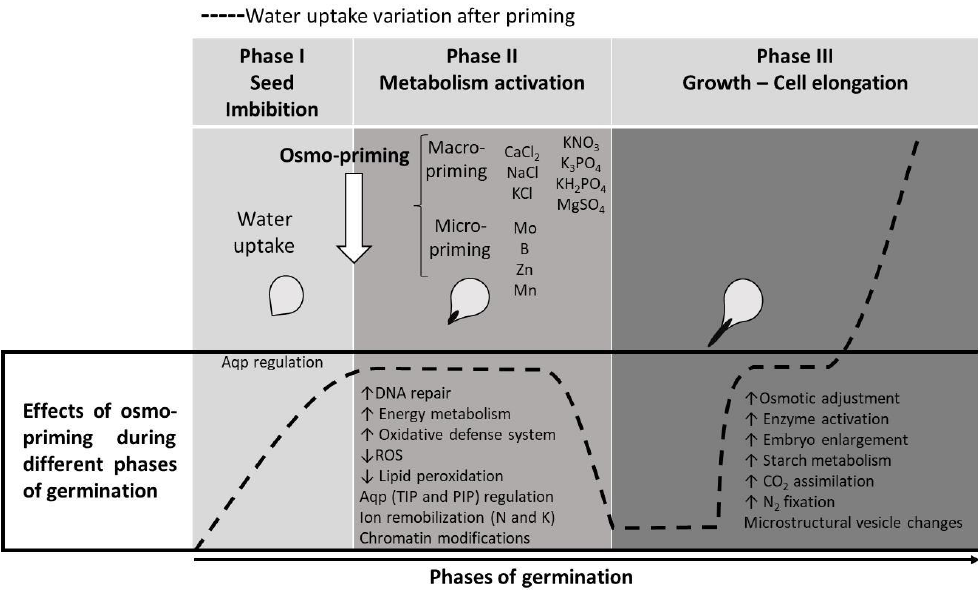
Figure 2. Effects of osmo-priming on water content and different events in the seeds during the Figure 2. E ff ects of osmo-priming on water content and di ff erent events in the seeds during the phases phases of germination (adapted from [61]). of germination (adapted from